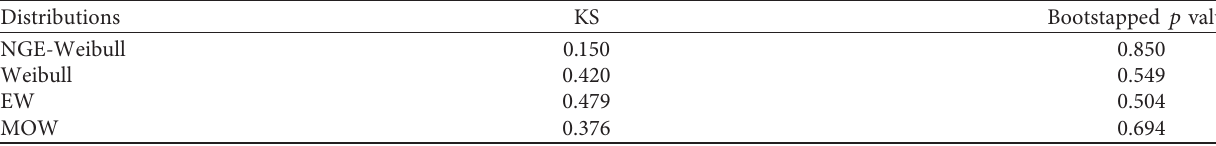
Table 6: The KS and the corresponding bootstrapped p value of the fitted models for the failure times of electronic components.